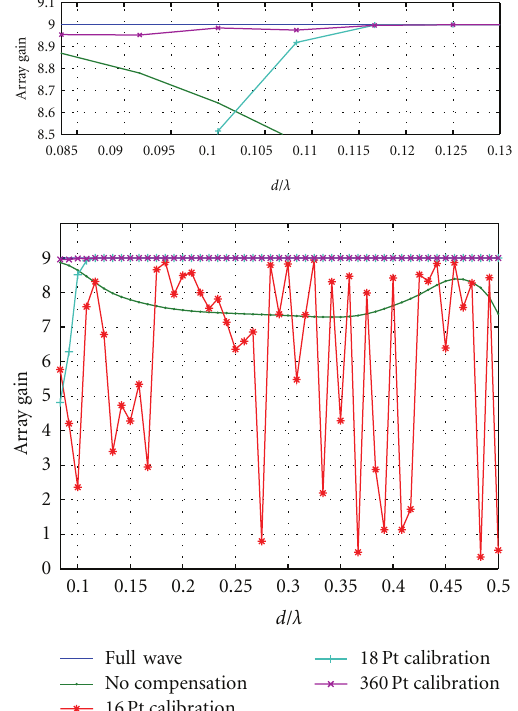
Figure 7: Array gain using the calibration method as a function of the electrical separation ( d/λ ) between the elements of the nine-dipole planar array for a signal arriving from φ = 0 ◦ . The performance of the calibration method is dependent on the number of calibration points. Instability in the estimation of the coupling matrix yields erratic performance for 16 calibration points. Maximum gain is reached at lower frequencies as the number of calibration points